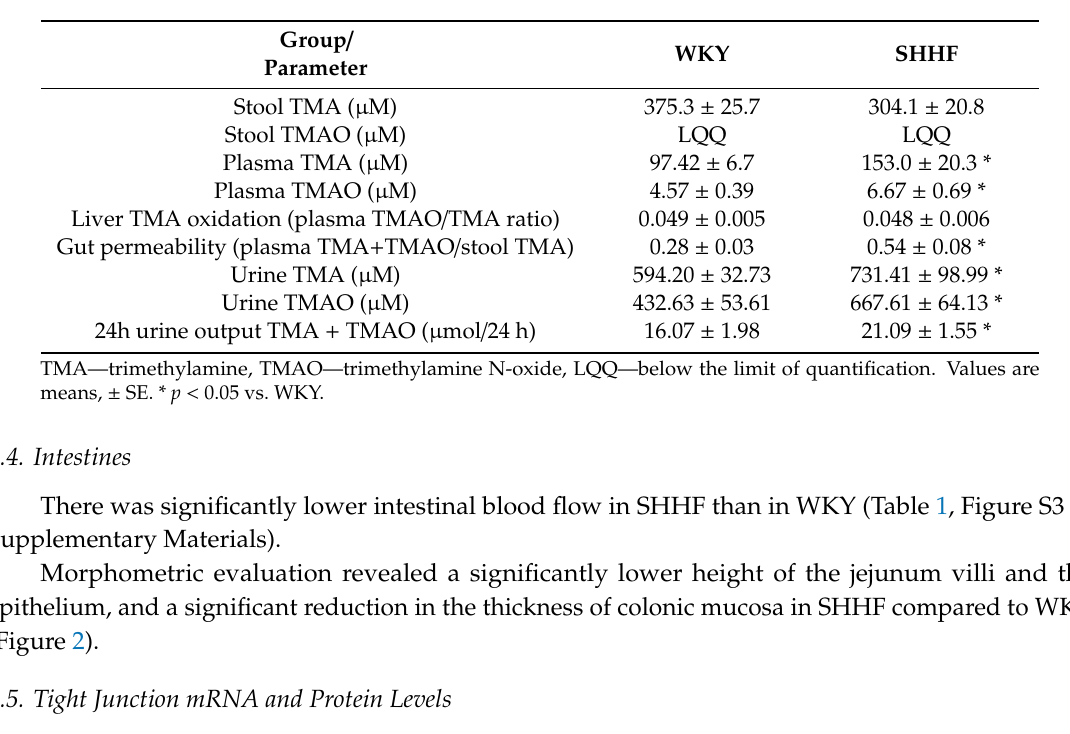
Table 2. TMA / TMAO balance in healthy Wistar Kyoto rats (WKY) and spontaneously hypertensive heart failure rats